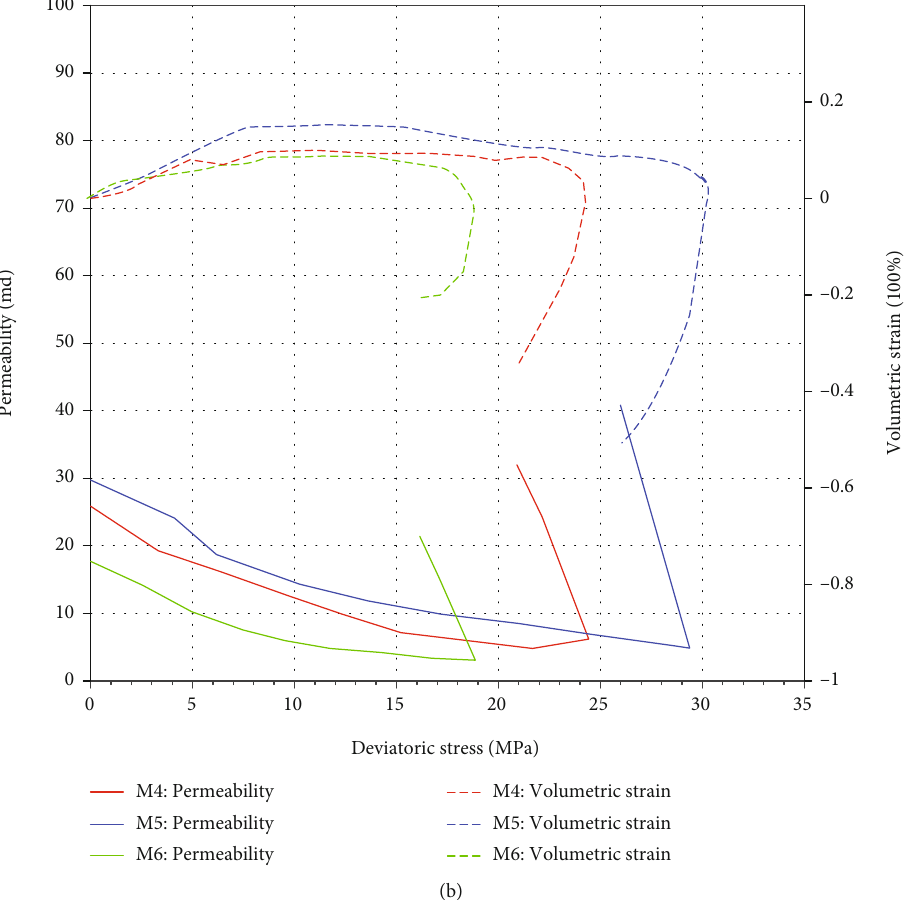
Figure 5: Relationship between volumetric strain permeability and deviatoric stress during the